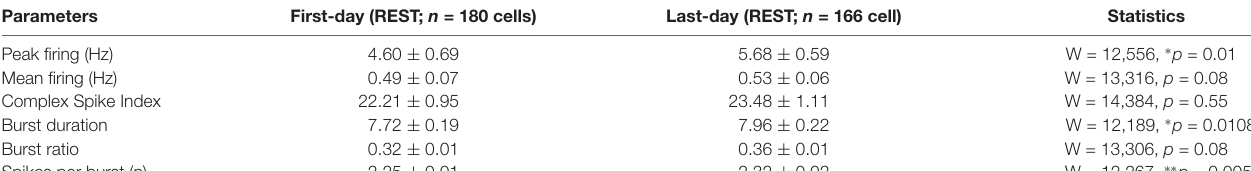
TABLE 1 | Pyramidal cell properties during baseline activity and exploratory states on day-1 and day-10.